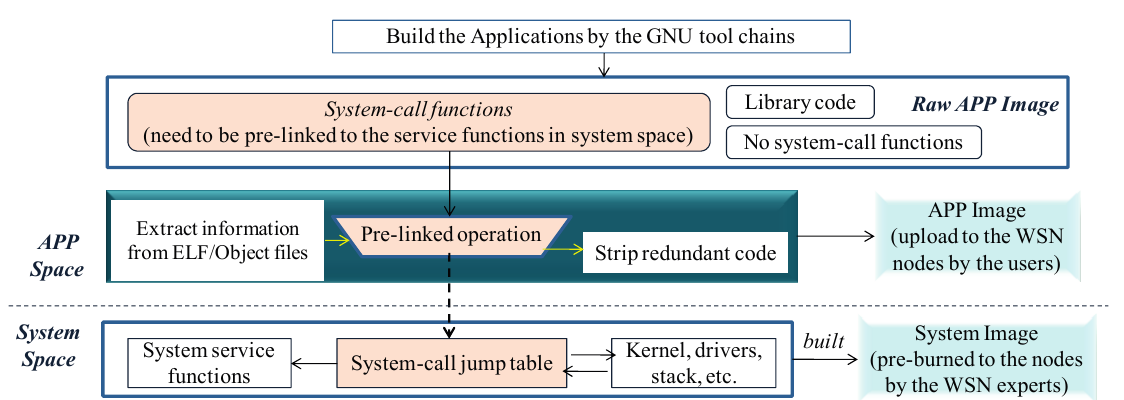
Figure 11. Elementary diagram of the EMIDE development process. The pre-linking is performed during the post-built